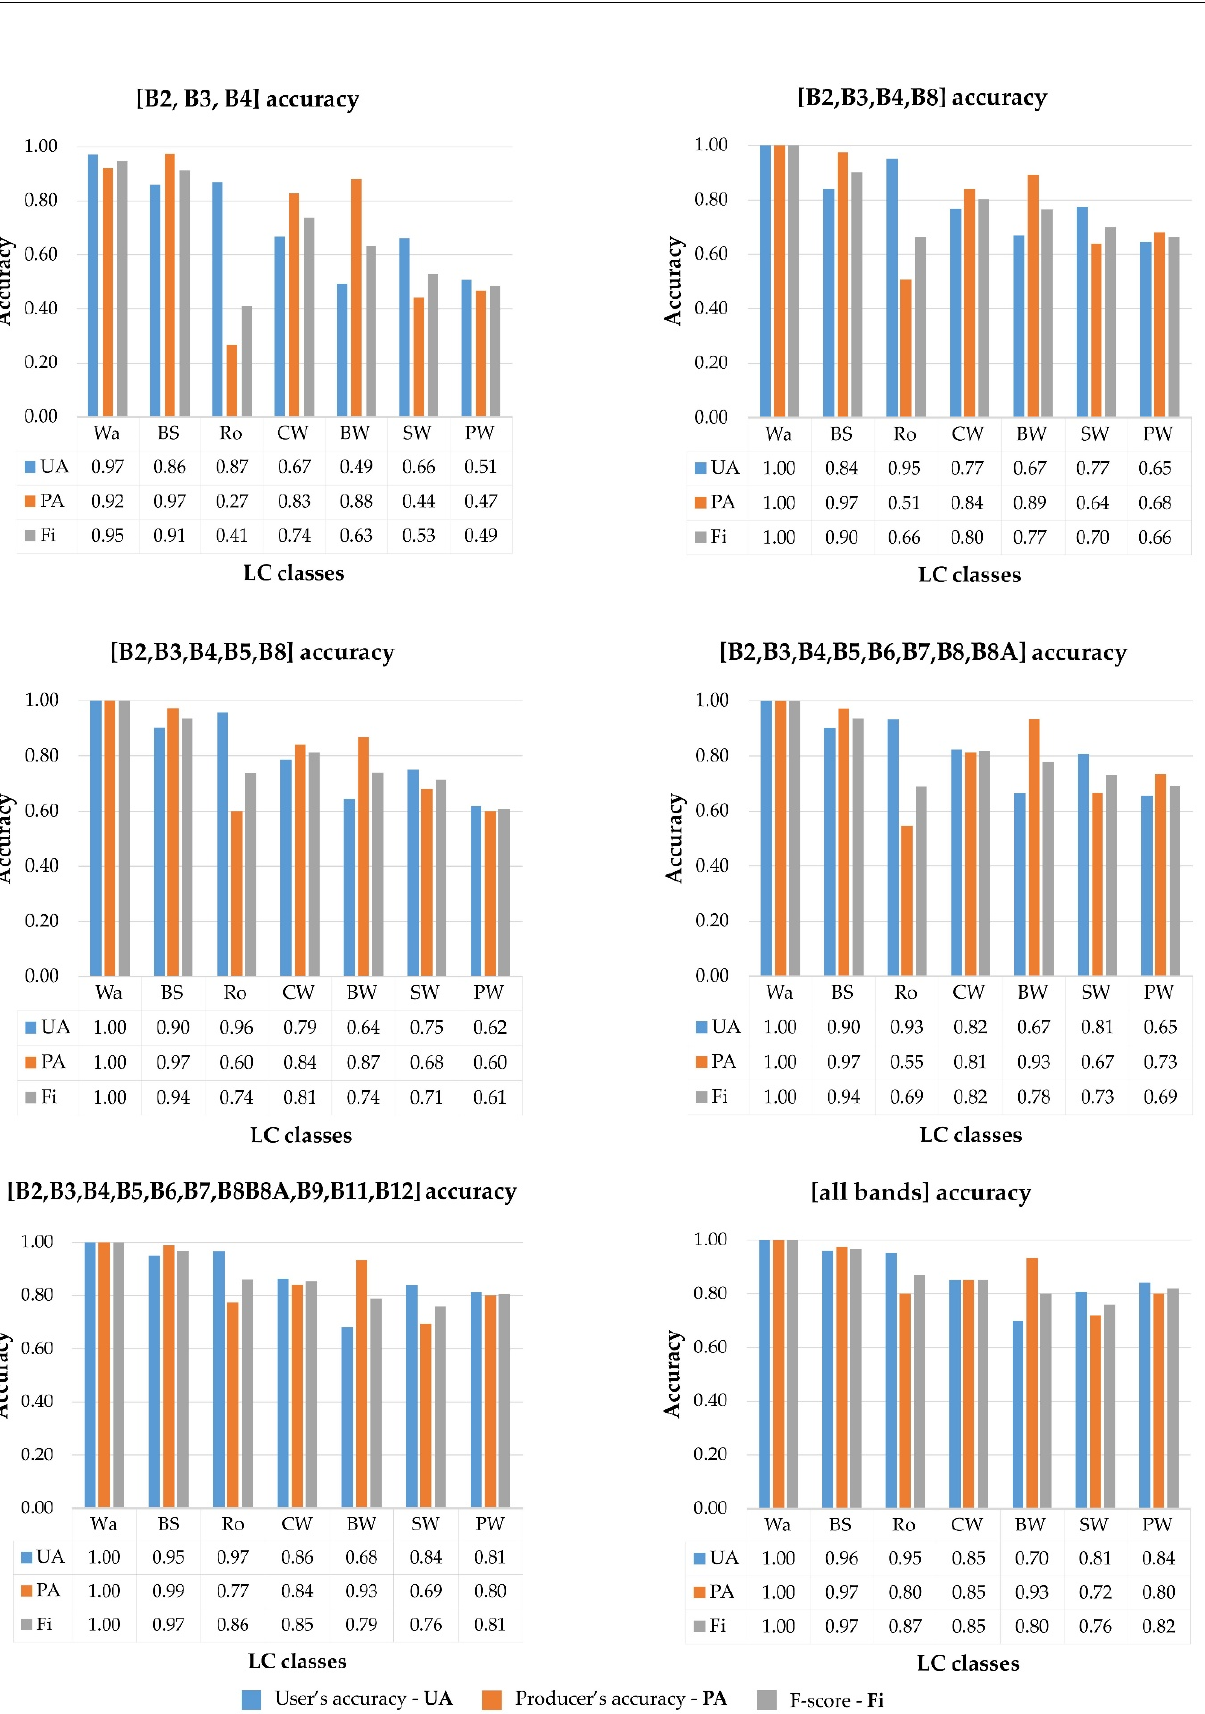
Figure A3. Band composition accuracy values, according to the land ‐ cover (LC) classes considered.